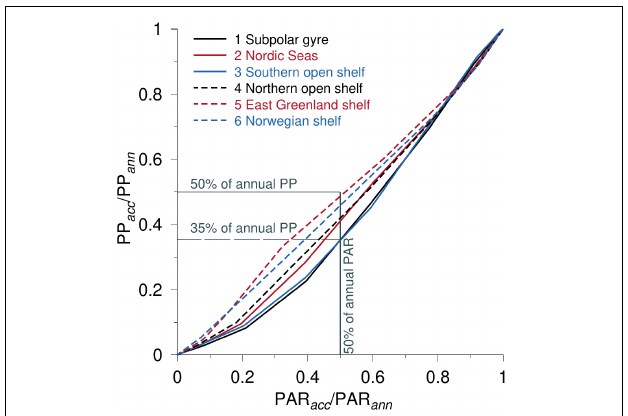
FIGURE 8 | Mixed layer depth in the six